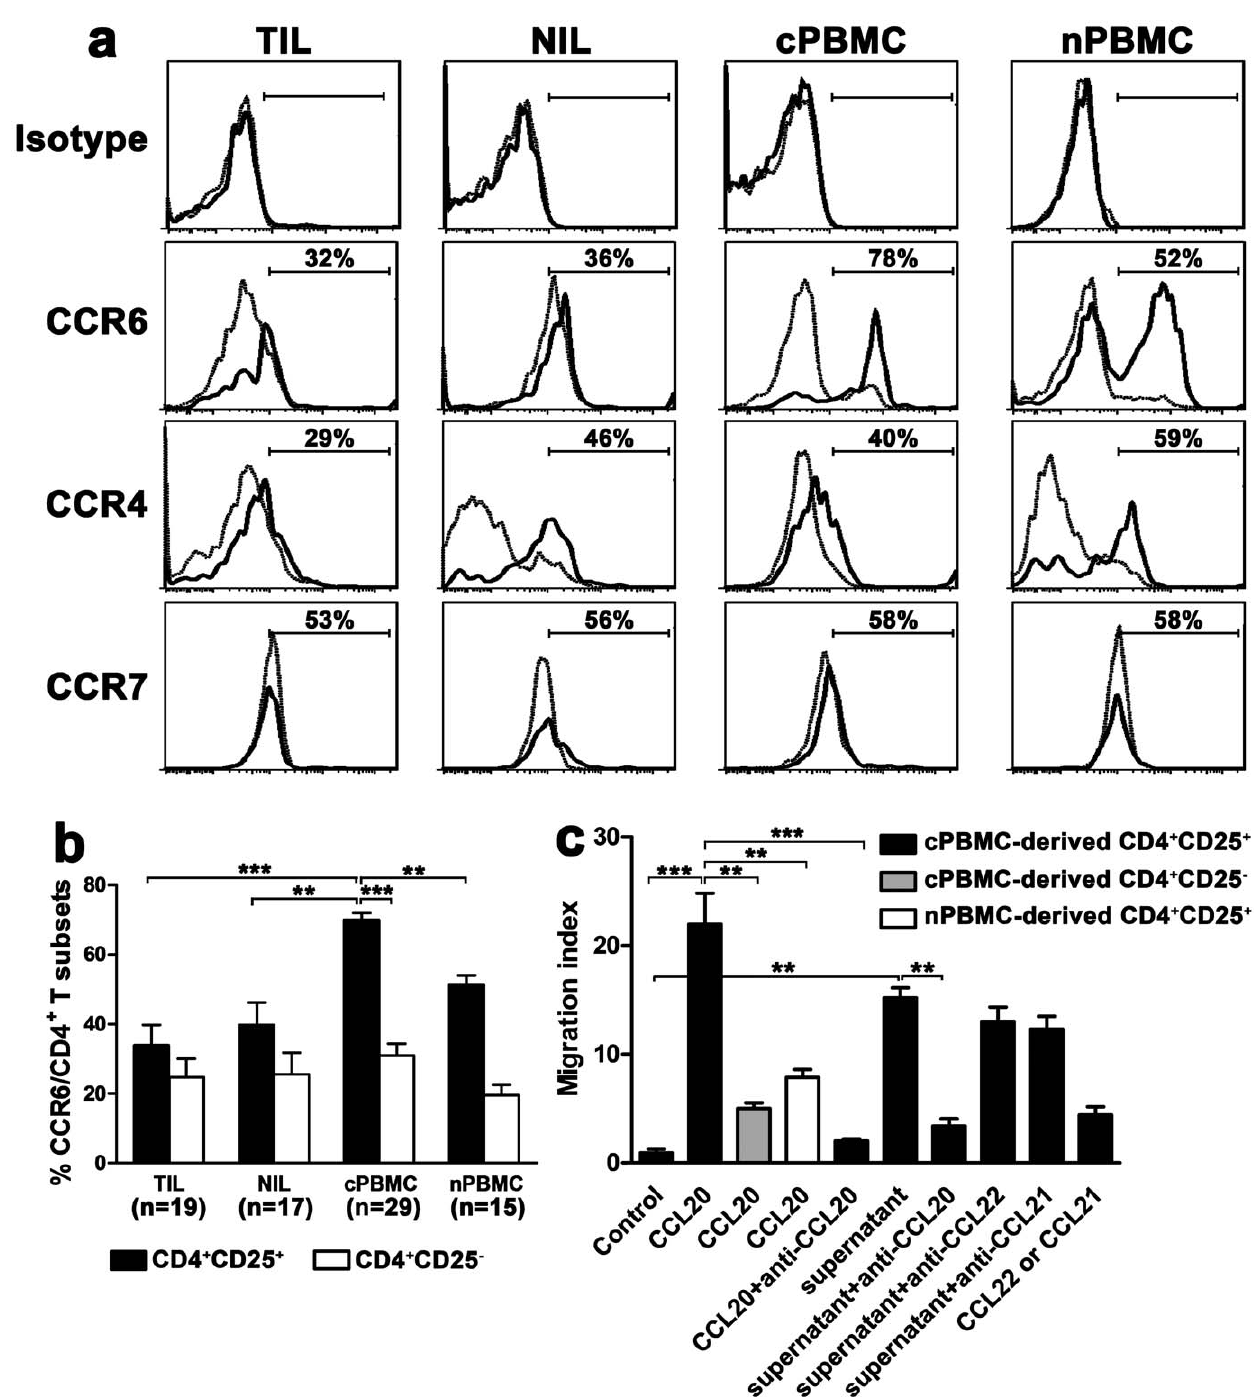
Figure 4. Circulating CD4 + CD25 + Tregs in HCC patients highly express CCR6, and selectively migrate to tumors under recruitment of CCL20. (a) Representative plots of CCR6, CCR4 and CCR7 on CD4 + CD25 + (solid line) and CD4 + CD25 2 (dotted line) T cells from different compartments. Specific isotypes were used as negative control. The percentages represent frequencies of CCR6, CCR4 and CCR7 on CD4 + CD25 + T cells. (b) Statistical analysis shows that cPBMC-derived CD4 + CD25 + Tregs expressed significantly higher CCR6 than autologous CD4 + CD25 2 T cells or Tregs from the other groups. ** P , 0.01, *** P , 0.001. (c) CD4 + CD25 + T cells migrate in response to recombinant human CCL20 or supernatant of SMMC-7721 cells (n=3). A specific antibody to CCL20 significantly inhibits CD4 + CD25 + T cell migration. Data represent the mean 6 S.E.M. ** P , 0.01, *** P , 0.001.